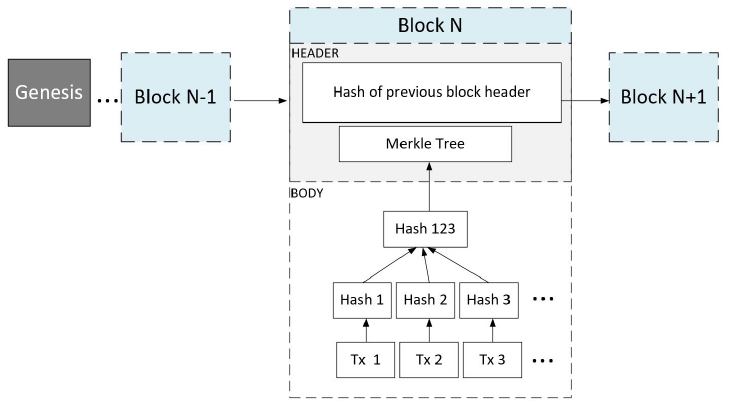
Figure 1. Blockchain